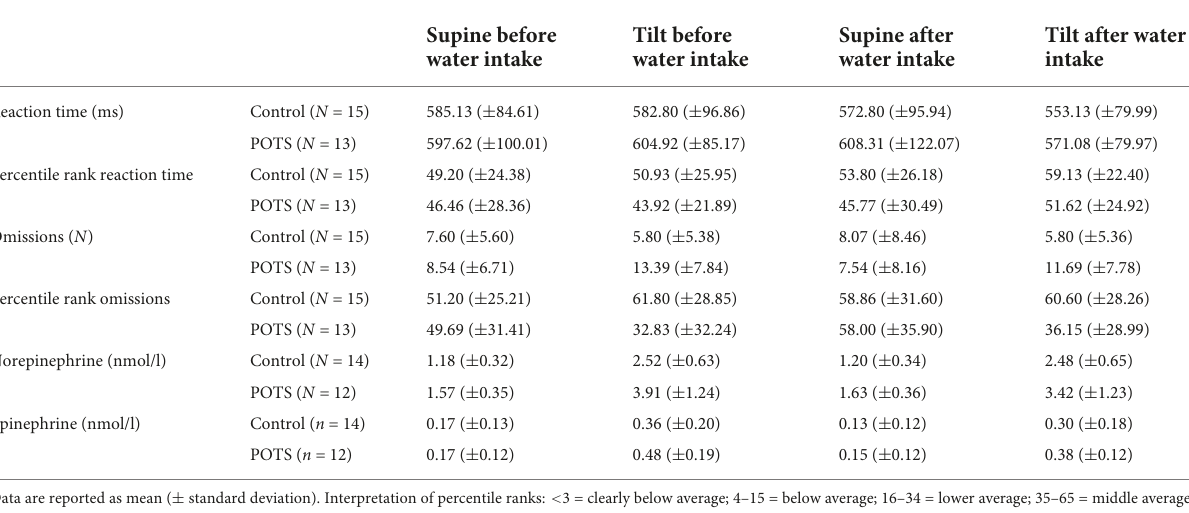
TABLE 3 Results of cognitive testing and assessments of plasma catecholamines.